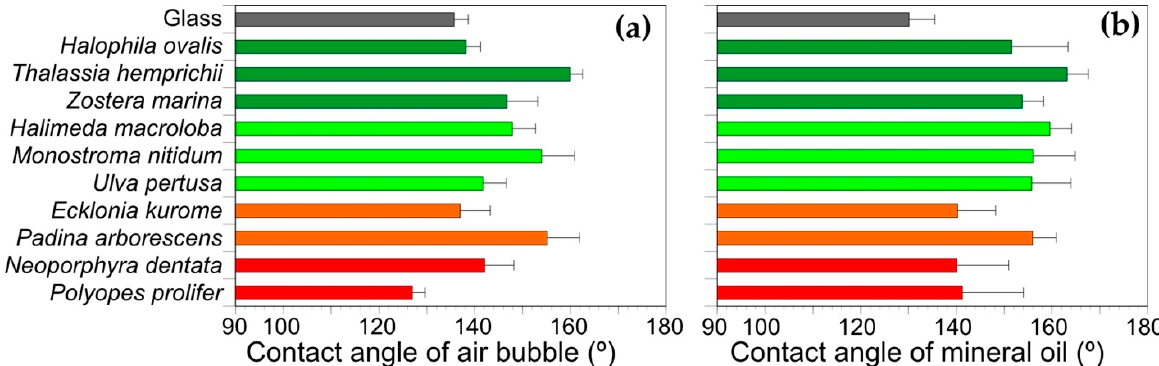
Figure 3. Contact angles of water droplets ( a ) and mineral oil ( b ) on glass (gray), seagrass (green), green alga (yellow green), brown alga (brown), and red alga (red). Fifteen to twenty measurements were carried out for each species in seawater (see Figure 2b,c). Error bars indicate standard deviations.